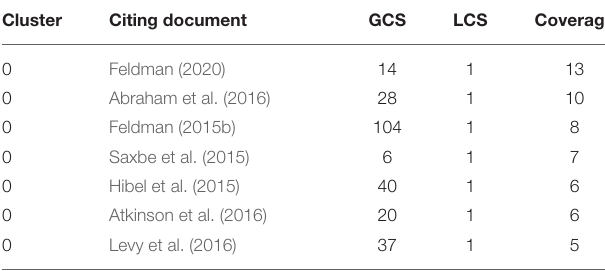
Values of global citing score (GCS), local citing score (LCS) and coverage are reported for the citing documents. GCS stays for the total number of citations a paper received in Scopus. LCS indicates the number of citations a paper received in the dataset of the current study. Coverage refers to the number of documents in the cluster that were cited by the